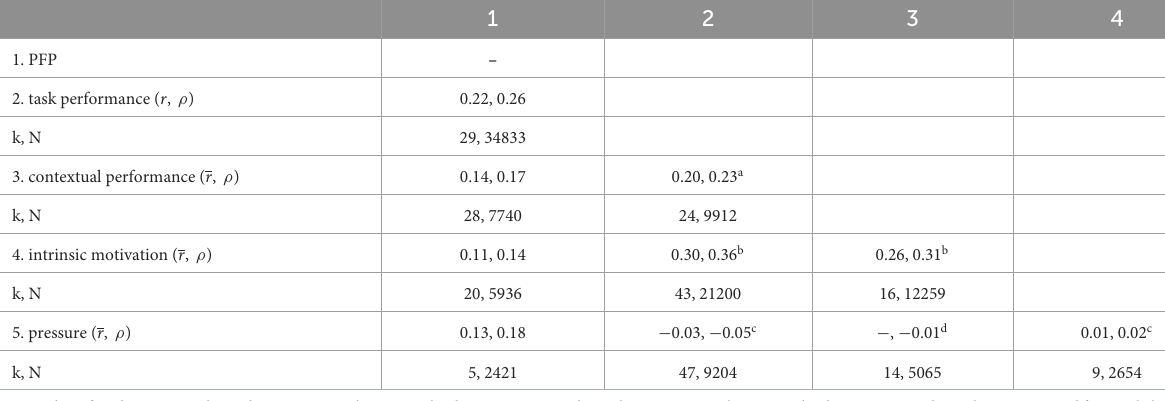
TABLE 2 Correlations among cognitive evaluation and job performance